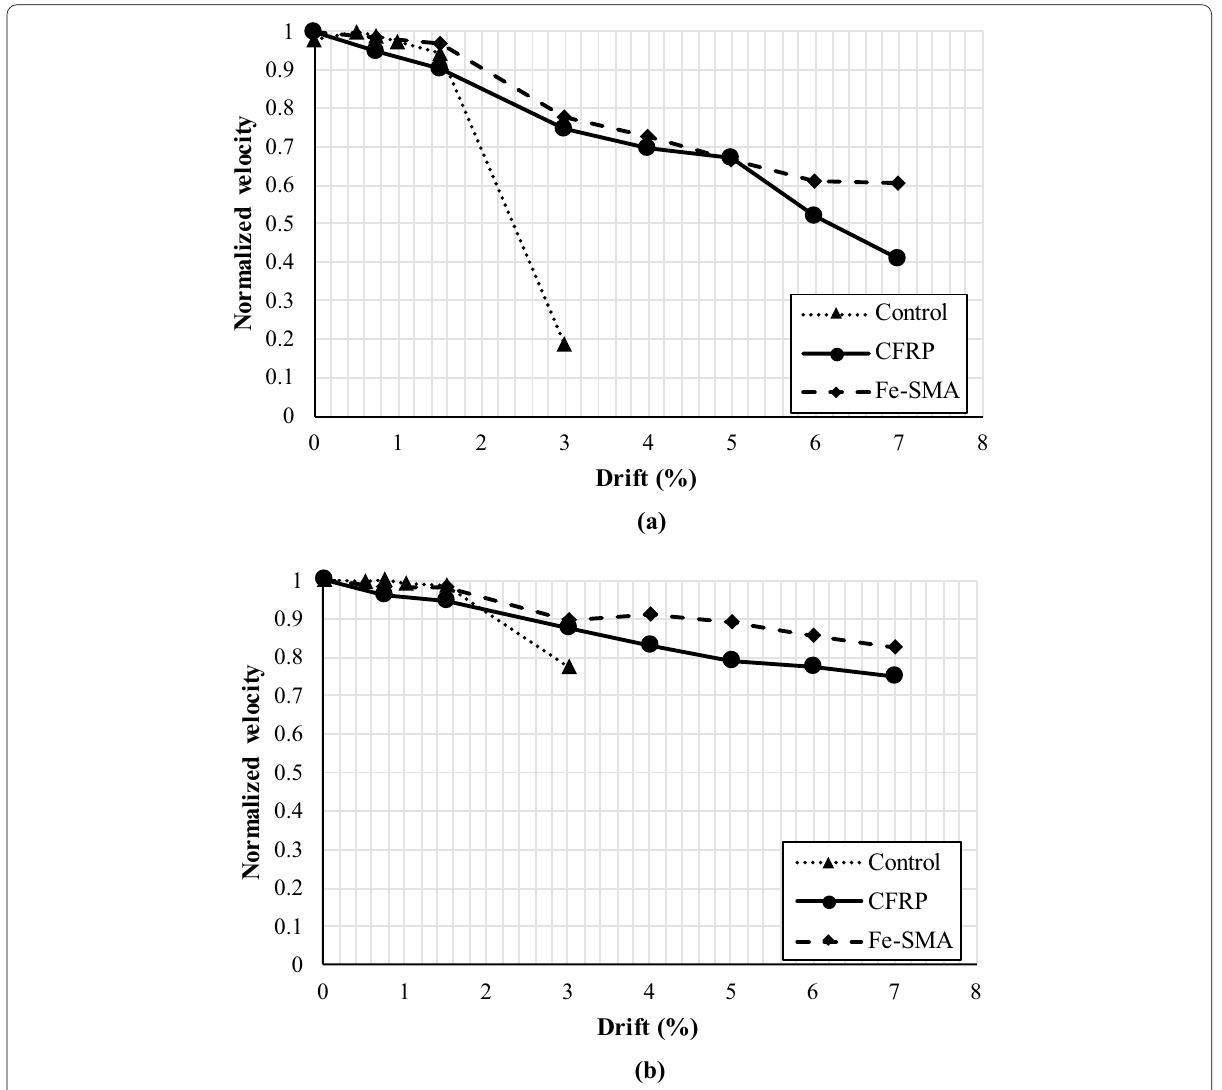
Fig. 12 Averaged through-thickness velocity: a forced direction; b non-forced